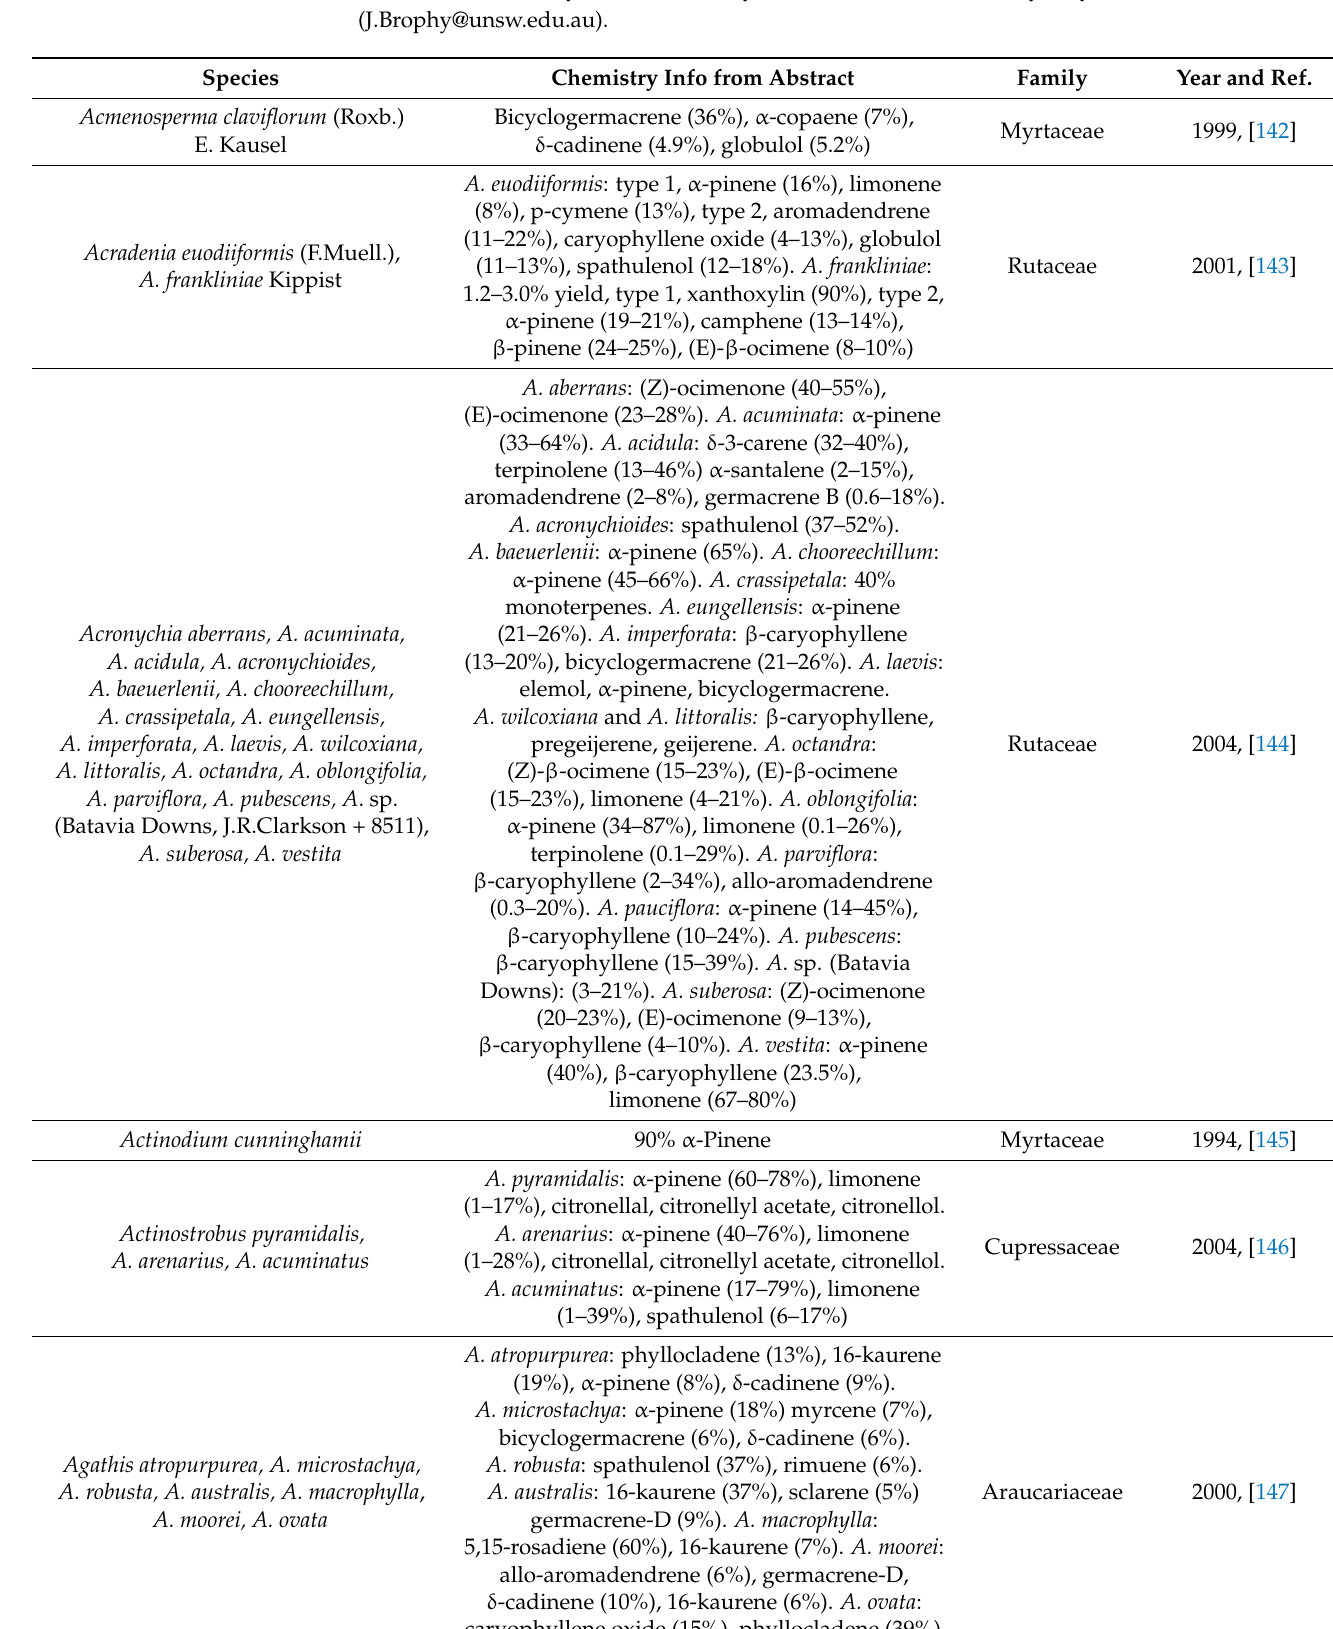
Table 1. Australian essential oils that were chemically studied by Joseph Brophy from